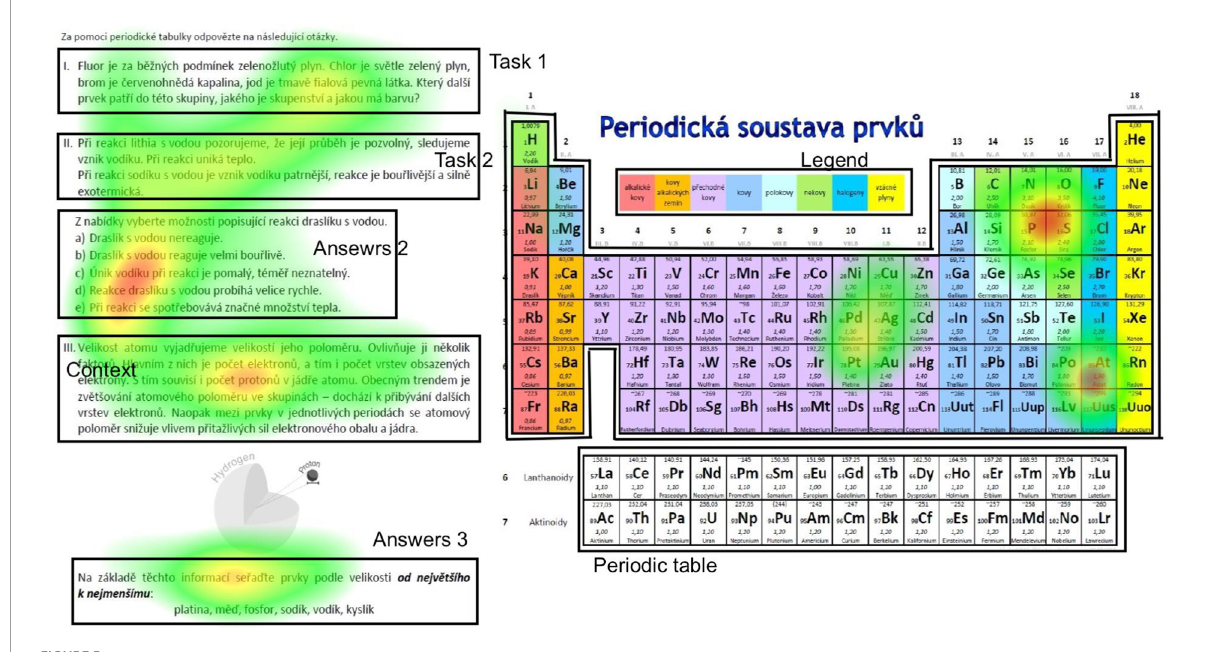
FIGURE5 Experts’ focus in the chemistry task.